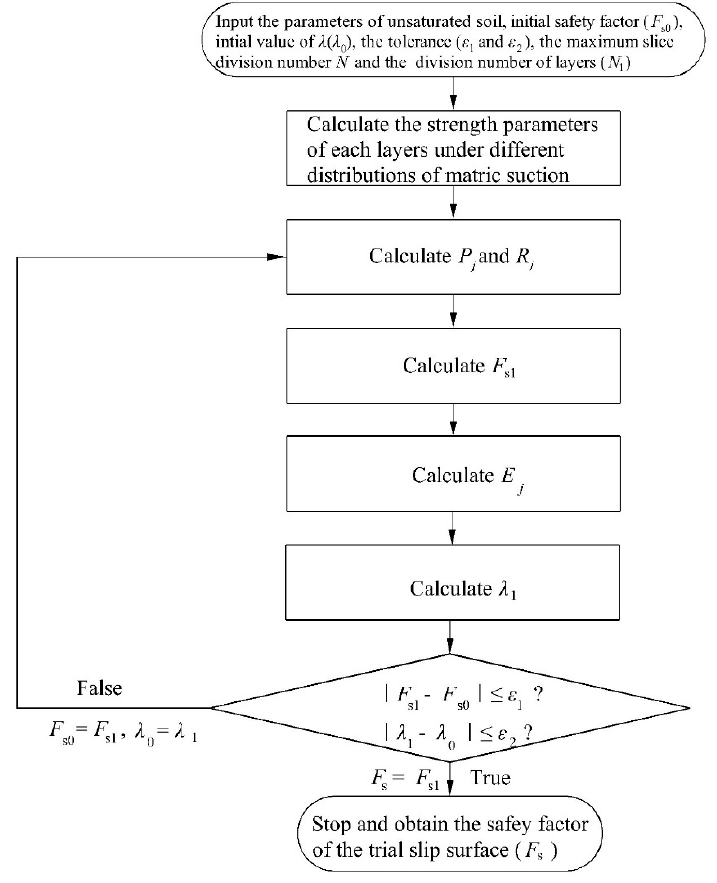
Figure 5. Flow diagram of modified M–P method.